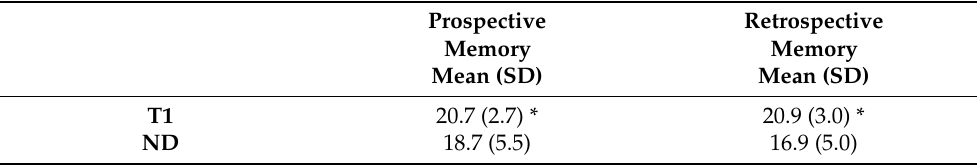
ND, normative data; SD, standard deviation. * p <